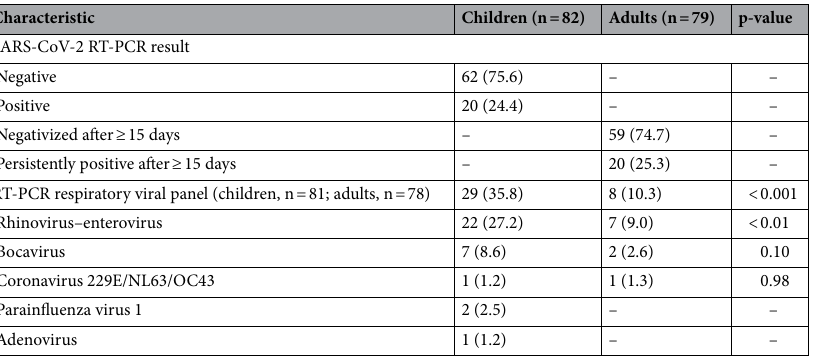
Table 3. Distribution of SARS-CoV-2 and other respiratory viruses in children and adults. SARS-CoV-2 acute respiratory syndrome coronavirus 2, RT-PCR reverse-transcriptase polymerase-chain